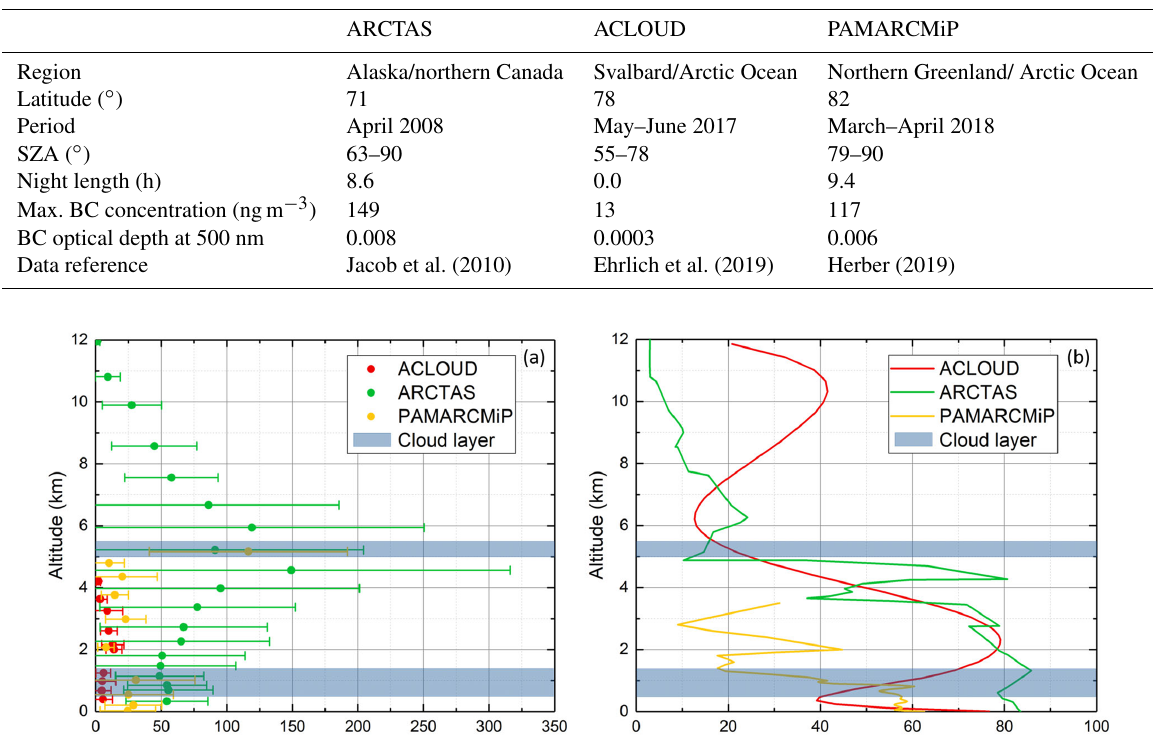
Table 2. Region, period, solar zenith angle range, and maximum BC particle mass concentration and mean optical depth of BC at the 500nm wavelength characterizing the three data sets obtained within ARCTAS, ACLOUD, and PAMARCMiP.